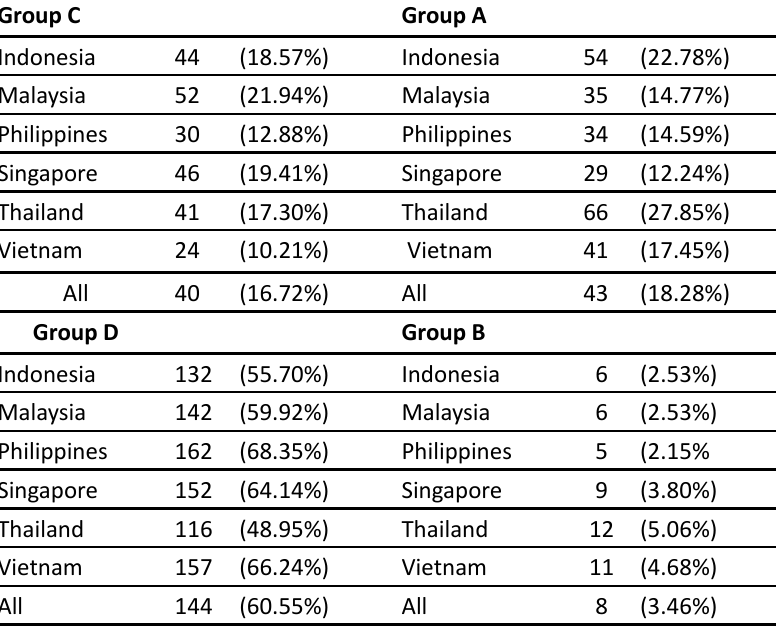
Table 1: Average Number of Product Groups A, B, C and D, 1997-2014 Group